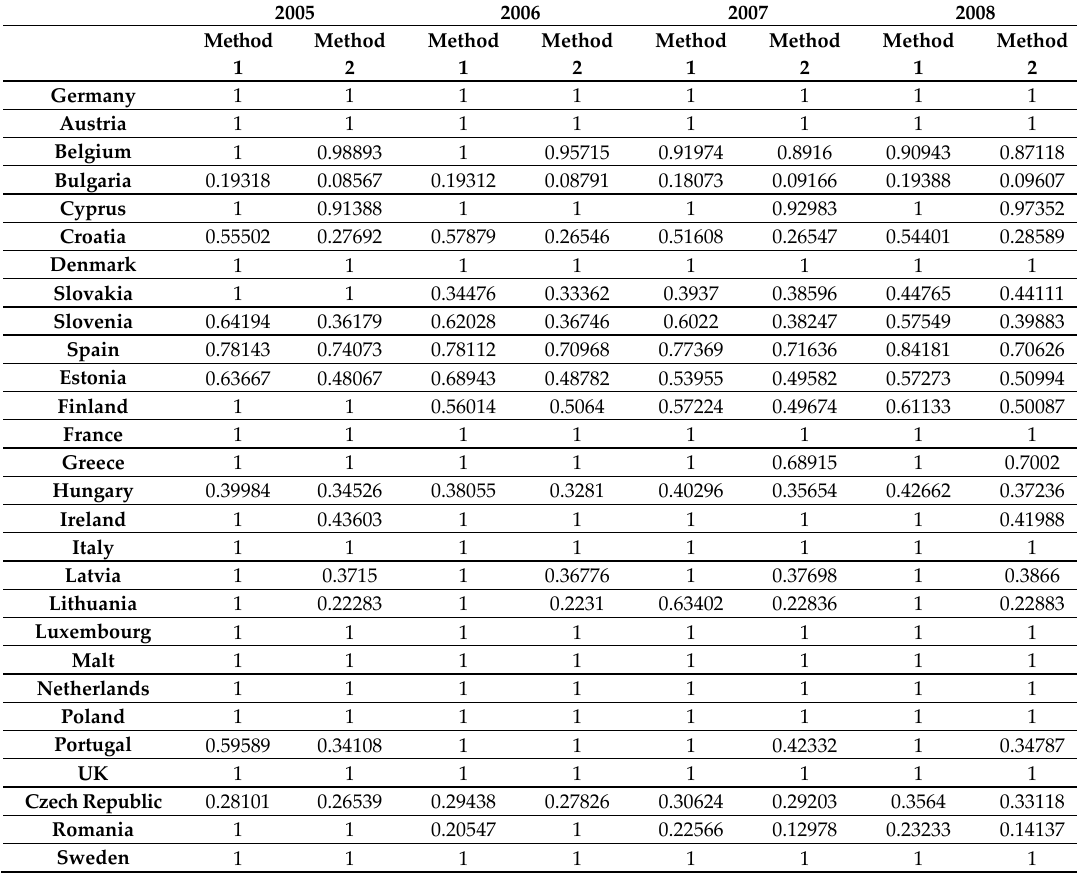
Table 7. Comparison of environmental efficiencies with Method 1 and with Method 2 for the 28 countries in the period 2005–2008. Source: self made.